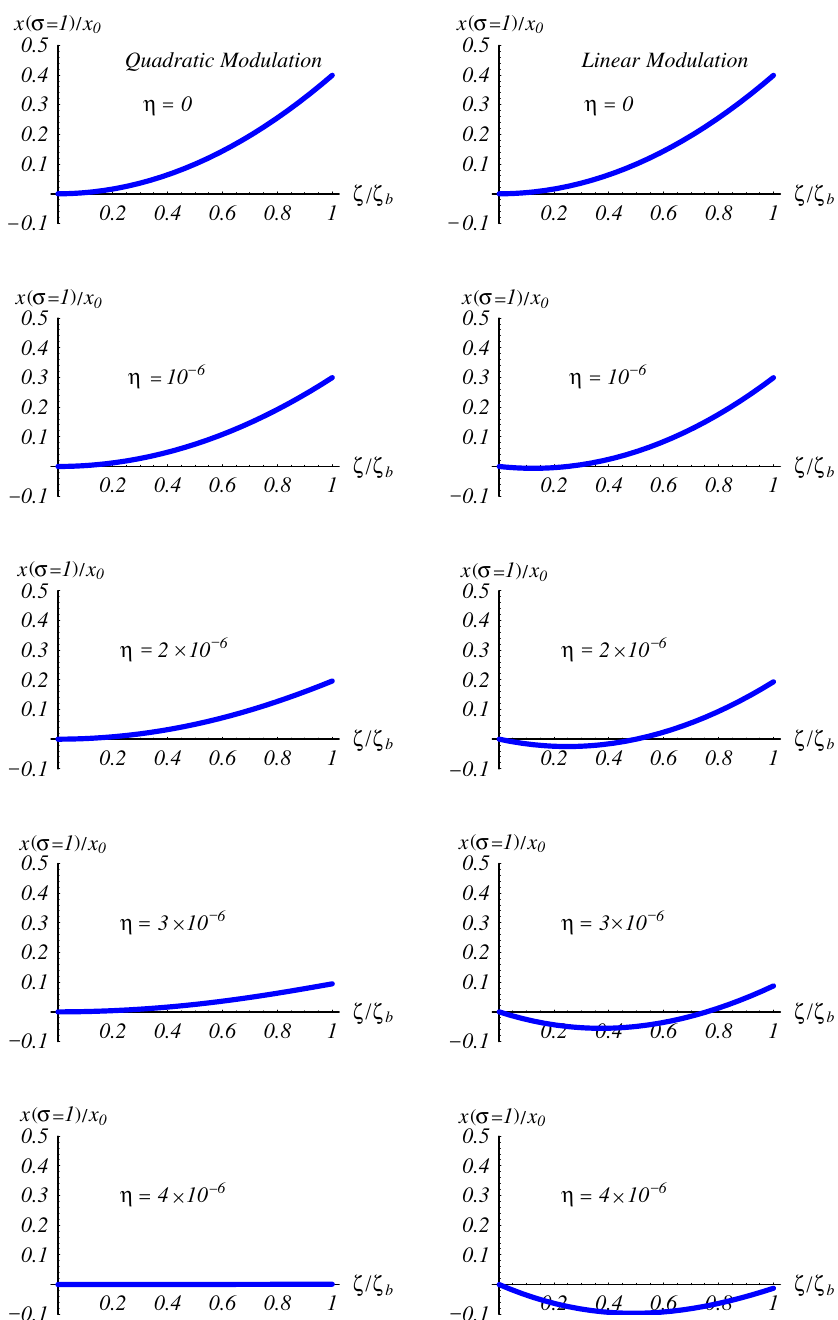
betatron motion without focusing modulation. The strength of the coupling to the dipole mode is assumed to be " (cid:7) 0 : 8 and the length of the bunch is assumed to be (cid:5) (cid:7) Figure 1 illustrates how the right amount of quadratic 0 modulation can cancel the effect of the coupling to the dipole modes, while a linear modulation can reduce it but not eliminate it.